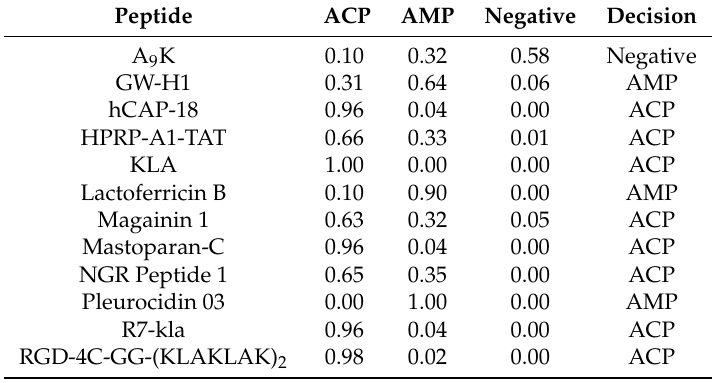
Table 7. Prediction results for experimentally verified ACPs targeting mitochondria of cancer